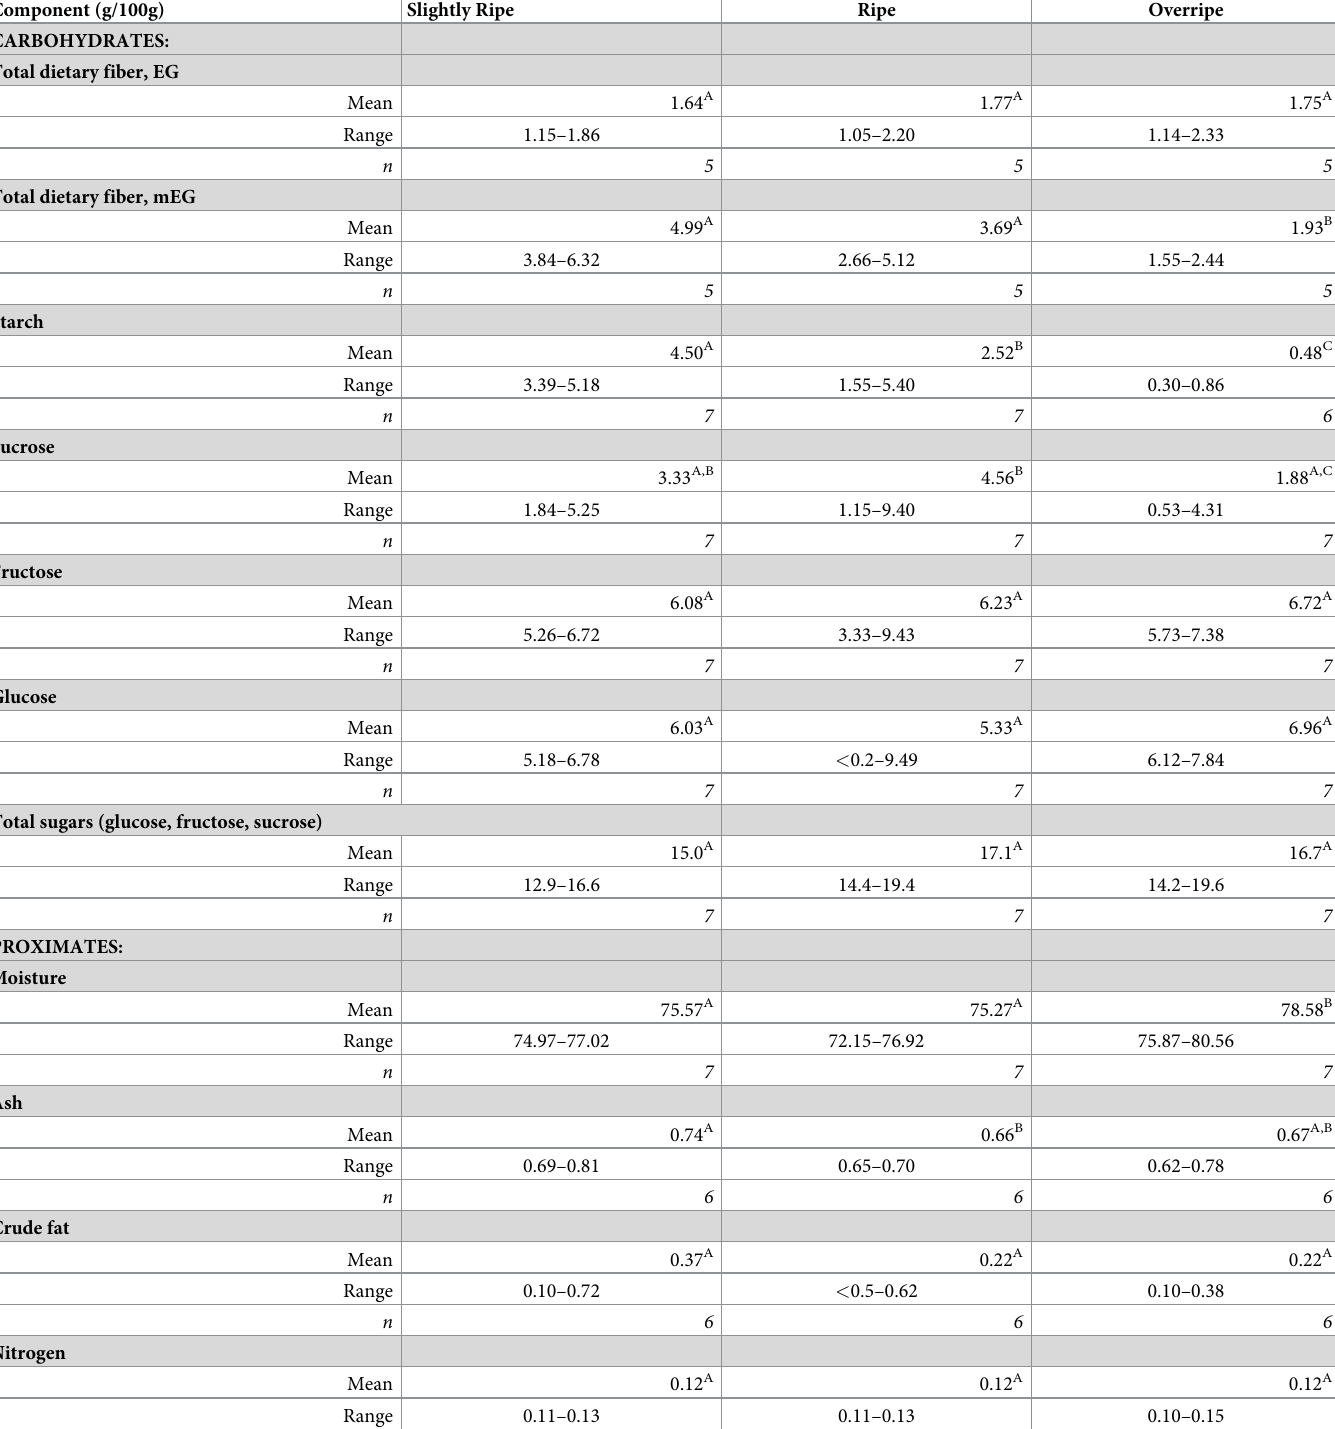
Table 2. Mean and range for dietary fiber, sugars, starch, and proximate composition of retail samples of bananas of different ripeness (unripe bananas were not analyzed in retail